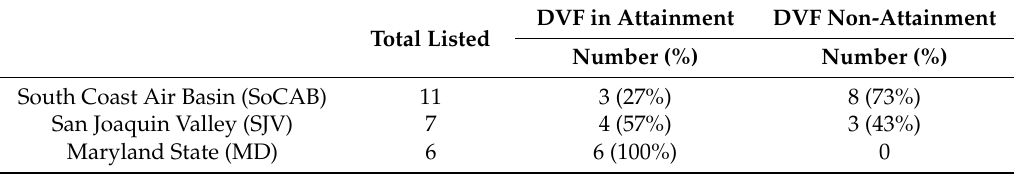
Table 2. Number of DVF attainment areas in the monitoring sites selected for